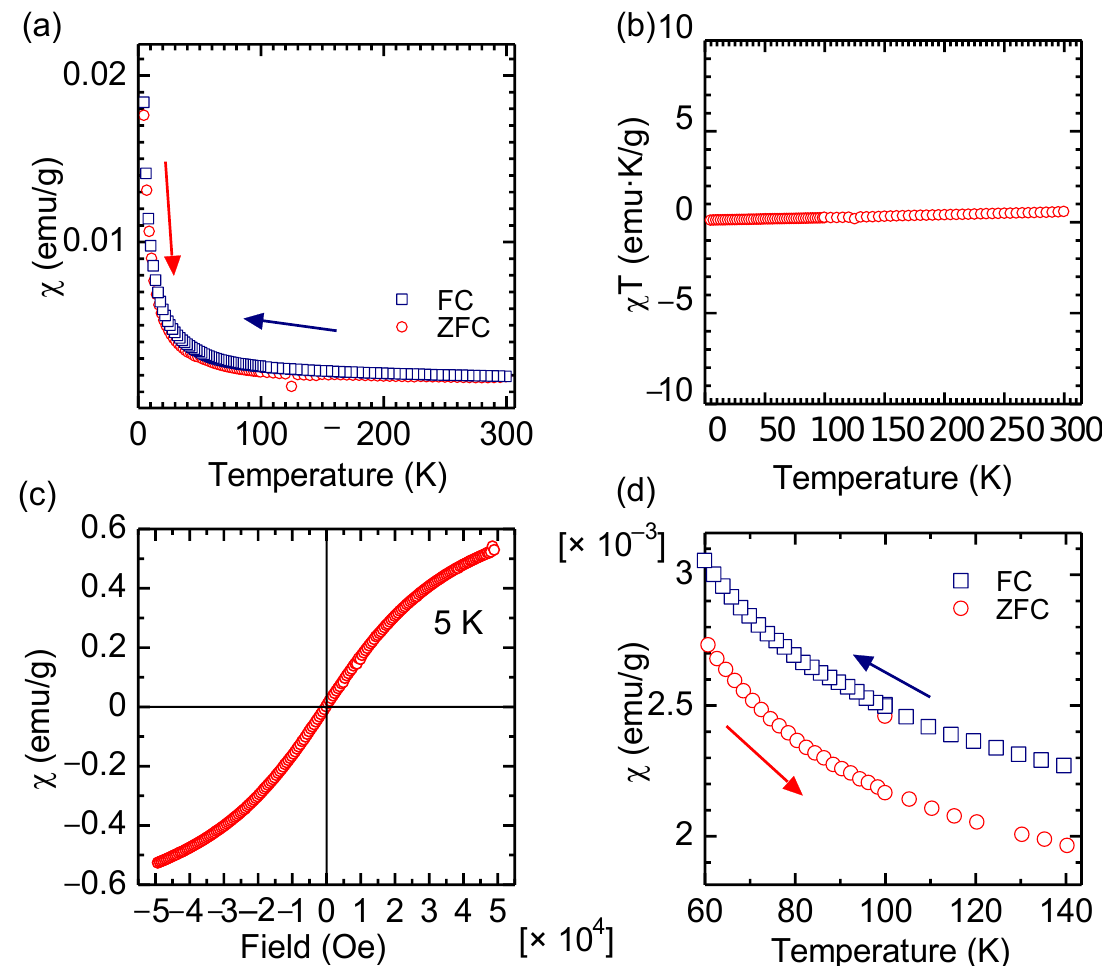
Figure 2. Magnetic measurements of Hb with a superconductor quantum interference device (SQUID). ( a ) χ vs. T curve. ( b ) χ T vs. T . ( c ) χ vs. magnetic field at 5 K. ( d ) Magnification of χ vs. T curve ( a ). χ : Magnetic susceptibility.